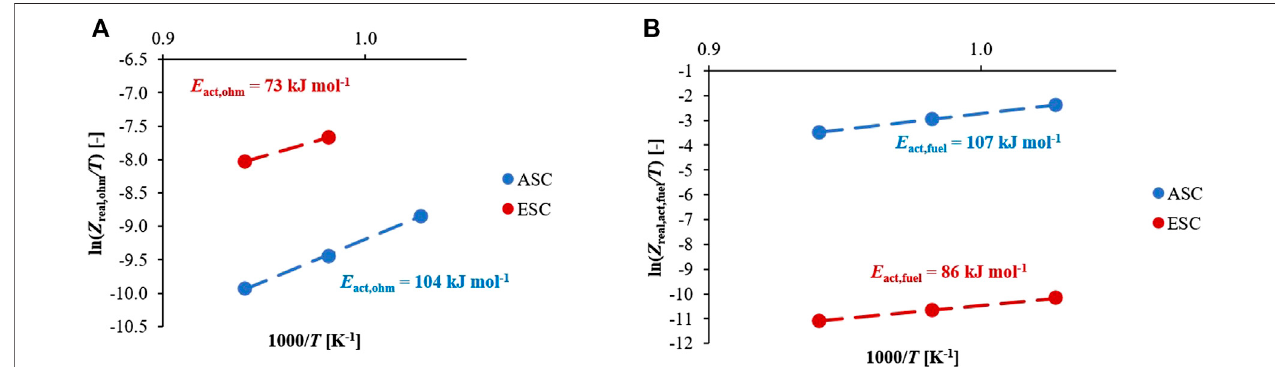
FIGURE 5 | Identi fi cation of temperature dependence based on the DRT analysis for both designs: (A) ohmic resistance of cell, (B) activation resistance of fuel electrode.